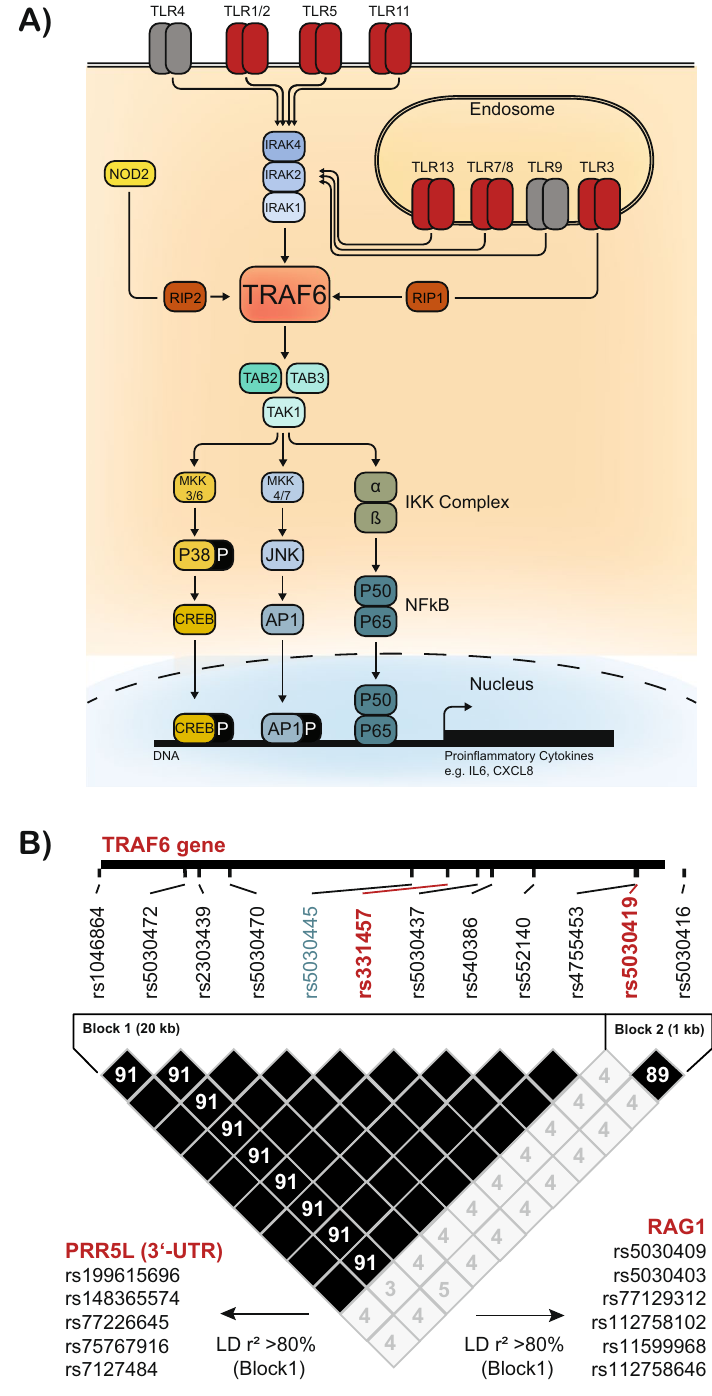
Figure 1. Schematic representation of TRAF6 immune function and TRAF6 haplotypes. ( A ) Schematic representation showing the role of TRAF6 for Toll-like receptor (TLR) and nucleotide-binding oligomerization domain-containing protein 2 (NOD2) signaling in innate immune cells. ( B ) Linkage disequilibrium (LD) plot with r 2 values illustrating the TRAF6 gene haplotype definition derived from HapMap data (HapMap release 28 Phase II + III, CEU population, forward strand, http://hapmap.ncbi.nlm.nih.gov) including single nucleotide polymorphisms (SNPs) with a minimum allele frequency of 0.05 and a Hardy Weinberg P value cut-off of 0.0010 are shown. The haplotype-tagging SNPs rs331457 and rs5030419 (red) and the validation SNP rs5030445 (blue) are indicated. Furthermore, SNPs in LD with rs331457 in neighboring genes are indicated as identified using HaploReg